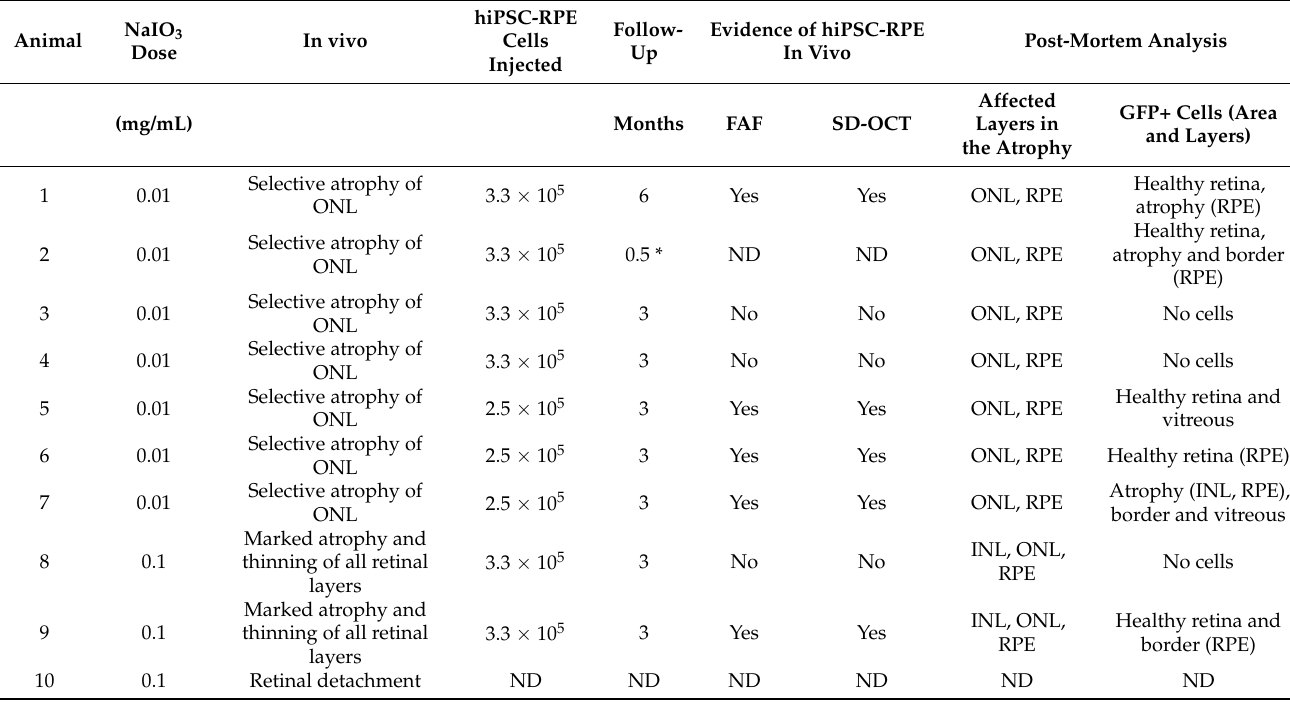
Table 1. List and details of procedures and findings of each animal in this